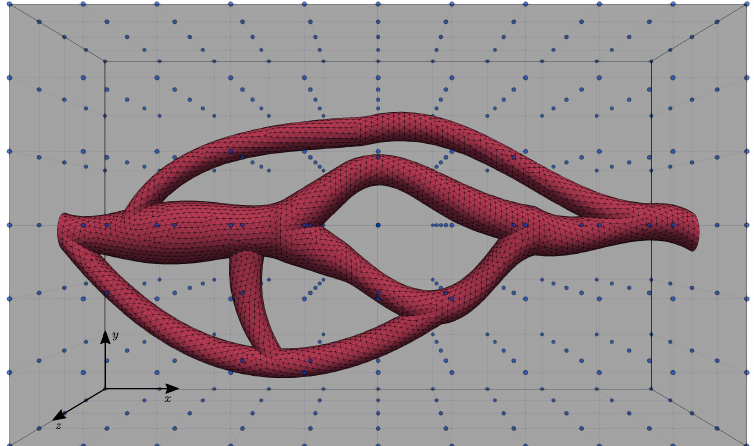
Figure 2. STL file of a blood vessel positioned in a cuboid computational domain. The blue dots correspond to the field (i.e., u x , u y , u z , p )